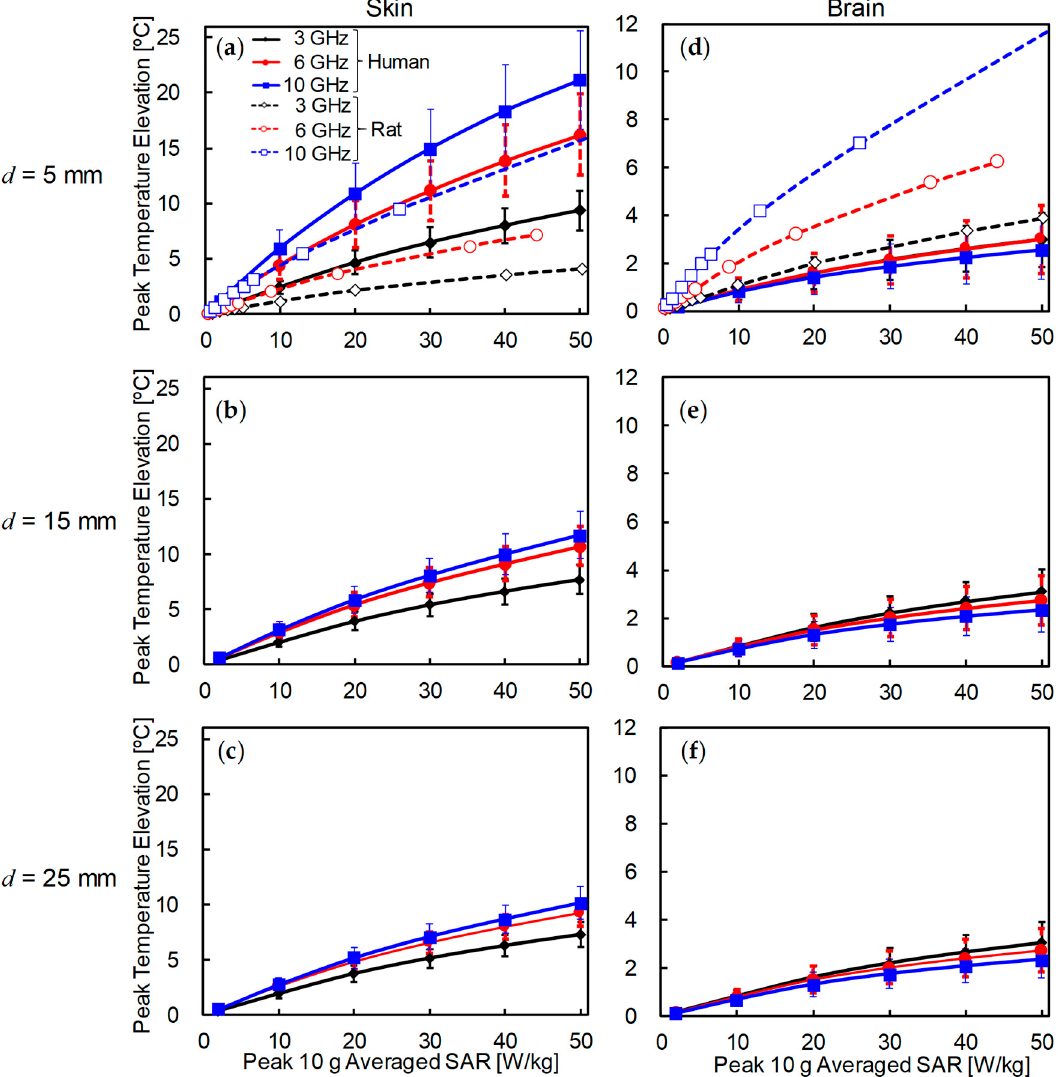
Figure 5. Peak temperature elevation of ( a – c ) skin and ( d – f ) brain for each peak SAR averaged over 10-g tissue. The distances between the skin surface and the dipole antenna d were set to ( a , d ) 5 mm, ( b , e ) 15 mm, and ( c , f ) 25 mm. Each point represents the average value and error bar showing the standard deviation ( n = 4). For comparison, the temperature elevation of rat brain tissue was also plotted.